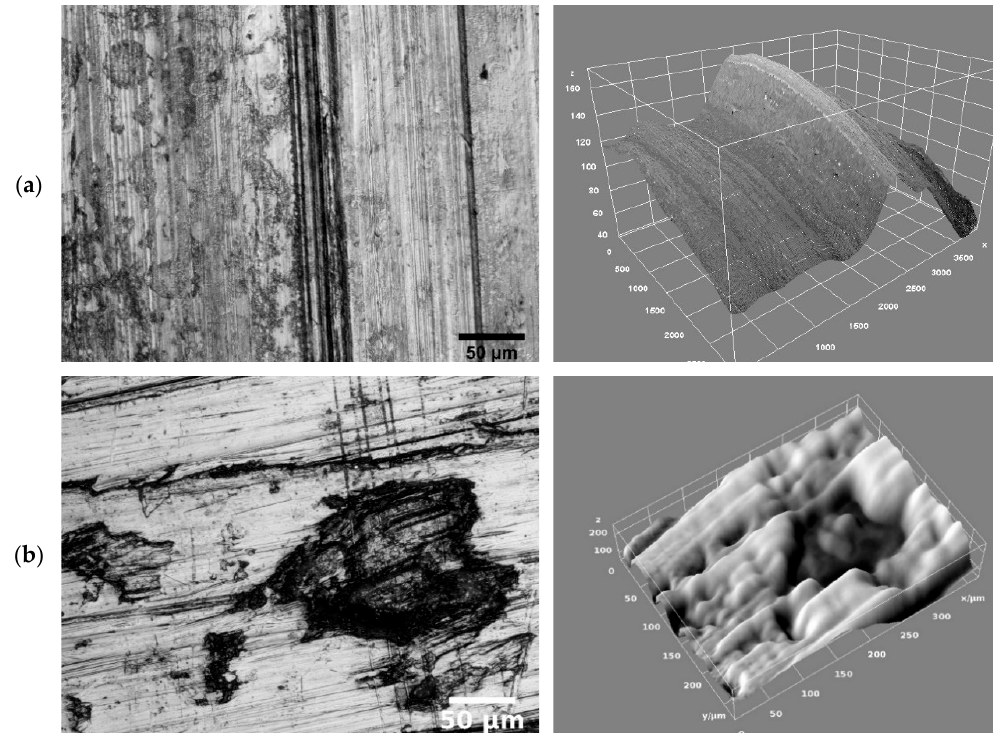
Figure 11. Detail of: ( a ) marks in back movement direction at the bottom of the hole, and ( b ) pit from the top zone of the hole ( b ). On left image processed with extended depth of field, on right topological from the top zone of the hole. On left image processed with extended depth of field, on right reconstruction. topological reconstruction.